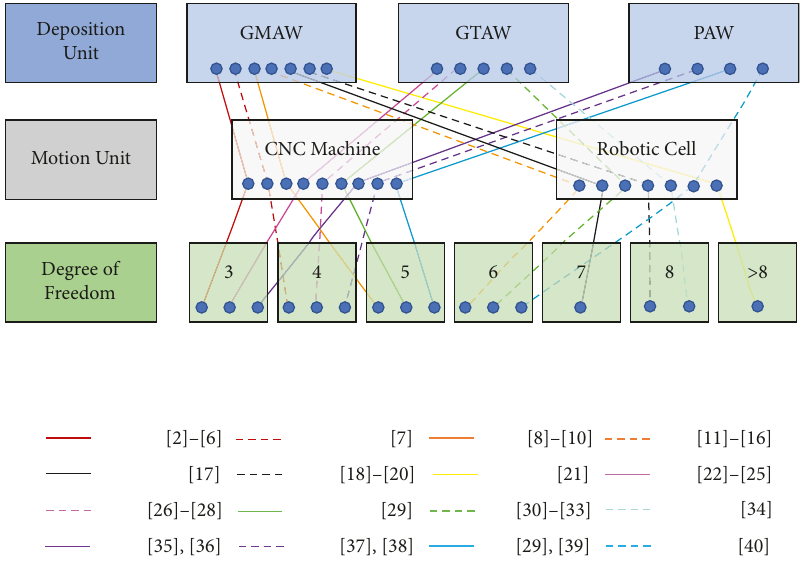
Figure 1: Classification of WAAM